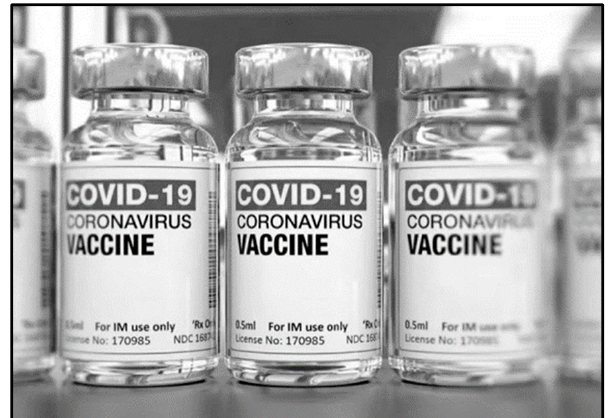
Figure A6. Immunization.